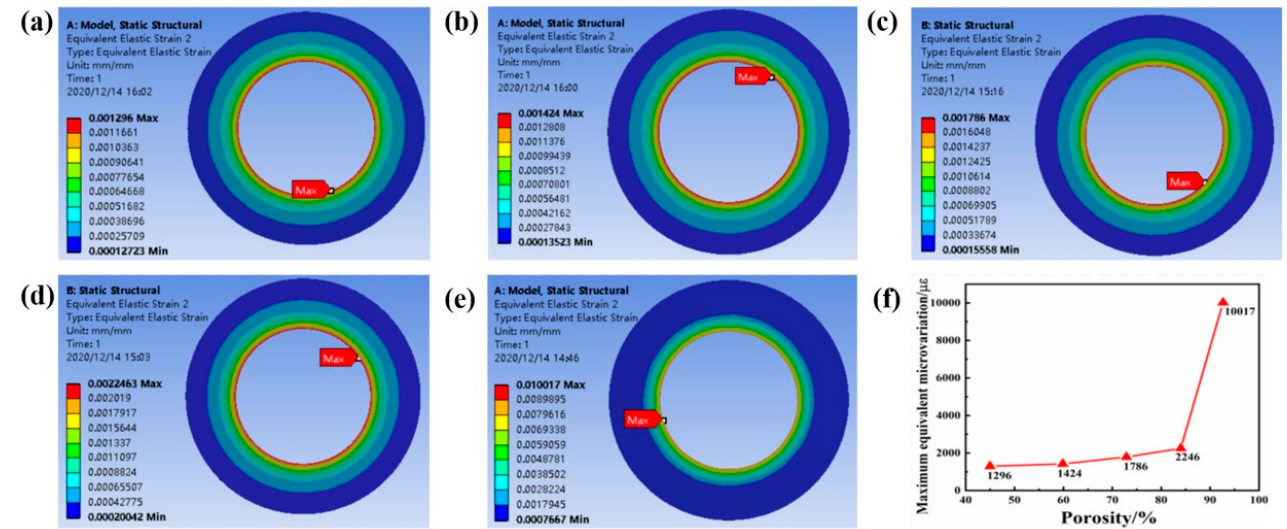
Figure 7. ( a – e ) Porosity 45–92.62%, equivalent strain cloud diagram and maximum equivalent strain line diagram of cortical bone around implants with different porosity under 200 N vertical stress. ( f ) The line graph of the maximum equivalent strain on the cortical bone near the implant of each structure.